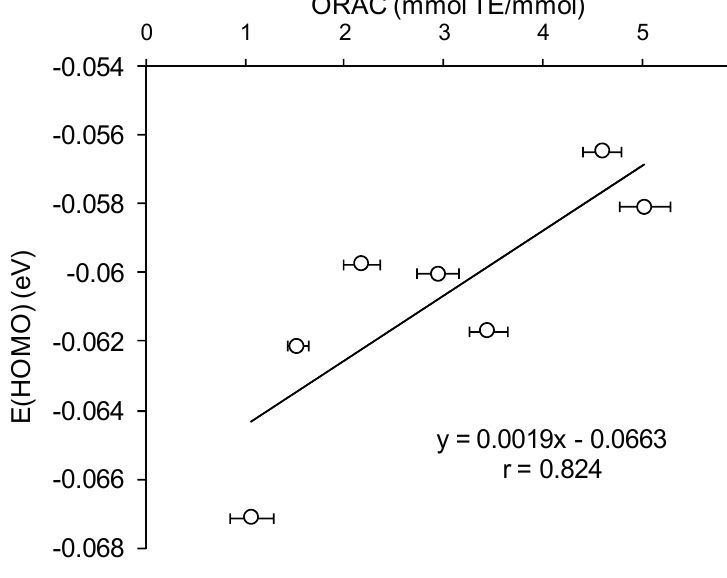
Figure 8. Correlation analysis of AOC against peroxyl radical for HB and HC acids versus HOMO energy